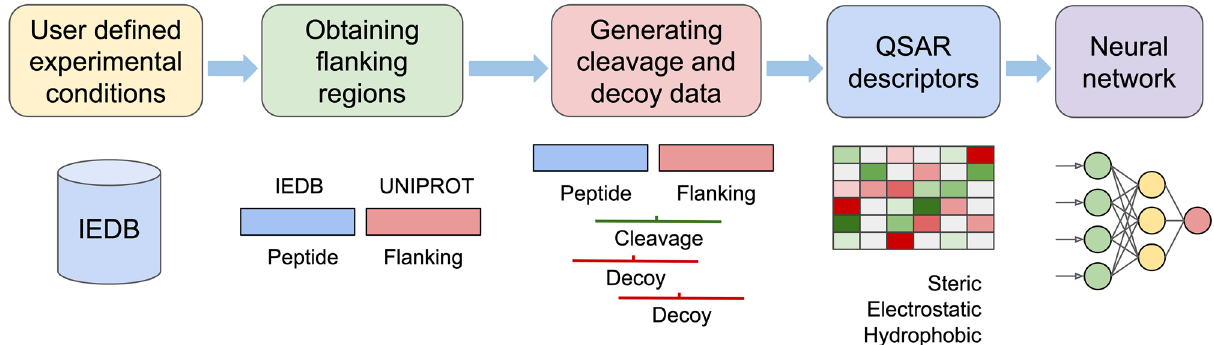
Figure 1. Overview of the NetCleave data preparation framework. Peptides reported by defined experimental conditions are automatically selected from the IEDB, and their C-terminal flanking residues are retrieved from UniParc/UniProt. Cleavage and decoy data of seven residue length are generated and encoded by 46 QSAR descriptors consisting of steric, electrostatic and hydrophobic